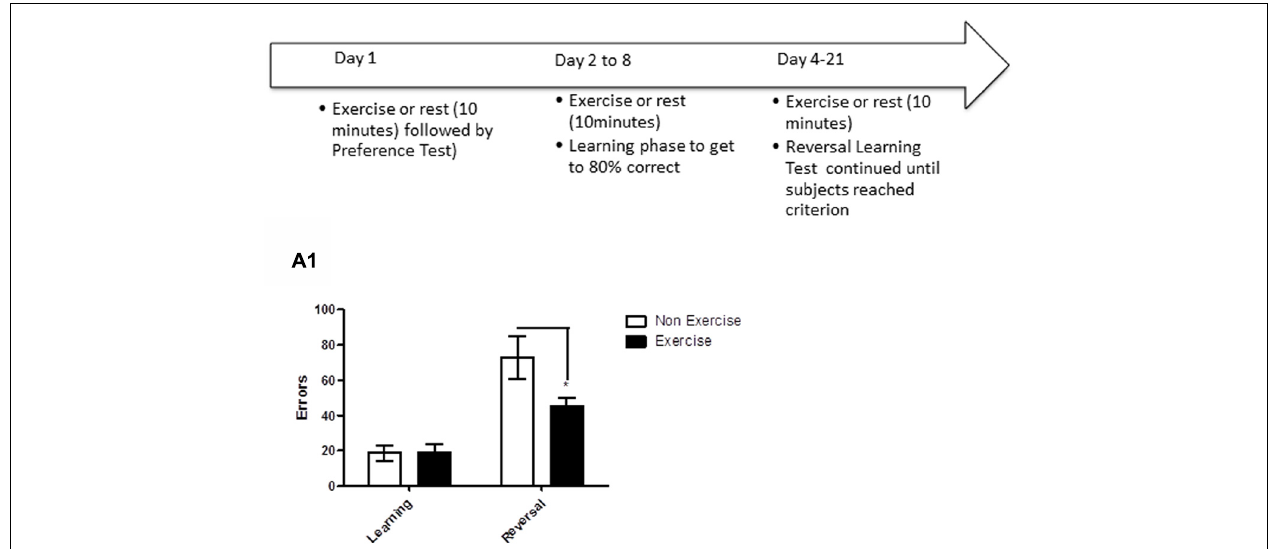
FIGURE 5 | Schematic showing testing of animals on the reversal learning task. After identifying each animal’s preferred/non-preferred objects for a given object pair on day 1, animals learned to associate a positive food reward with the preferred object over the next week. Once the criterion of ≥ 80% correct responses was reached in a day’s session, reversal learning was initiated. Animals were tested on the reversal phase until the animal achieved reached criterion ( ≥ 80% correct in a single session). For animals in the exercise group, each dog underwent daily exercise (10 min treadmill) immediately prior to the test session, beginning the day of preference testing and continuing through reversal learning.